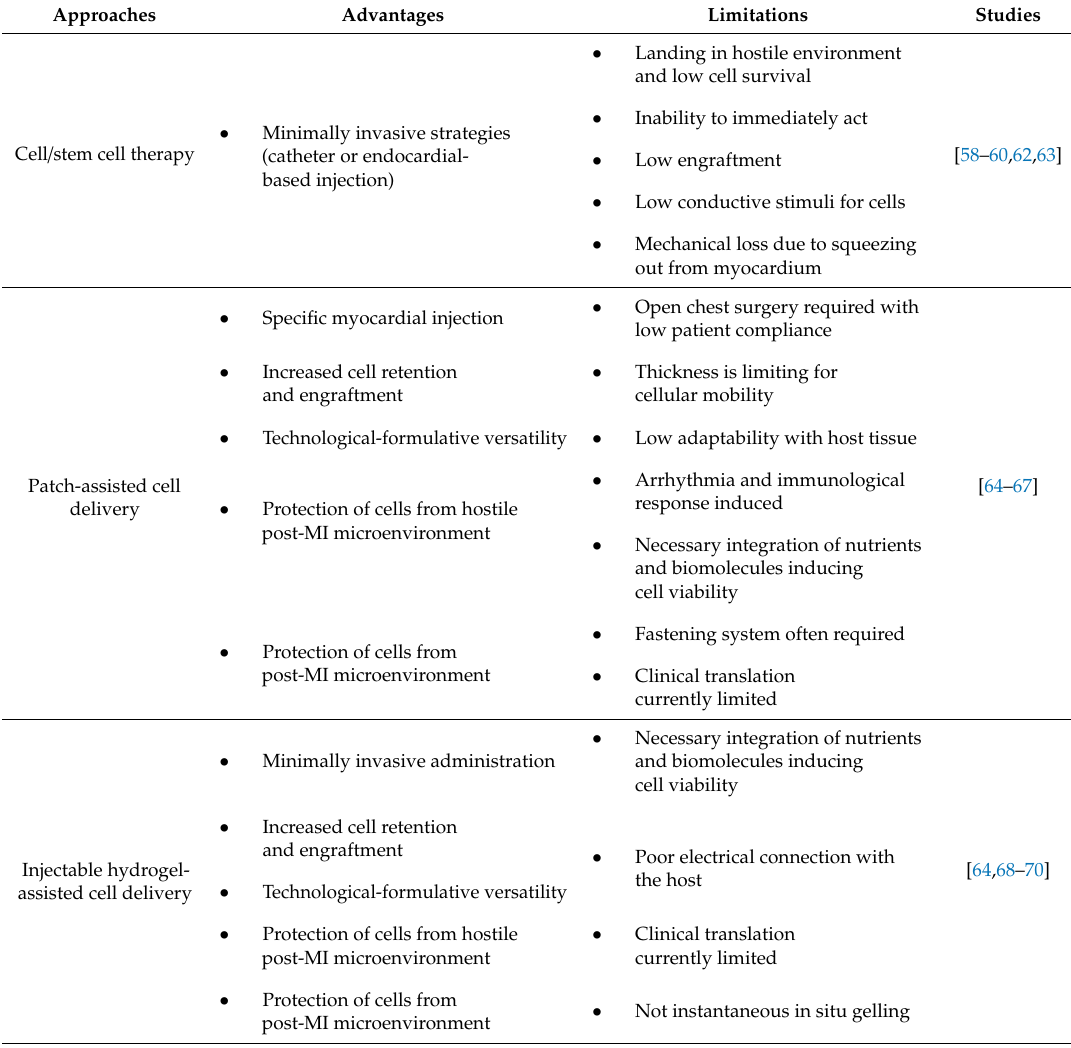
Table 1. A comparison of the most common tissue engineering